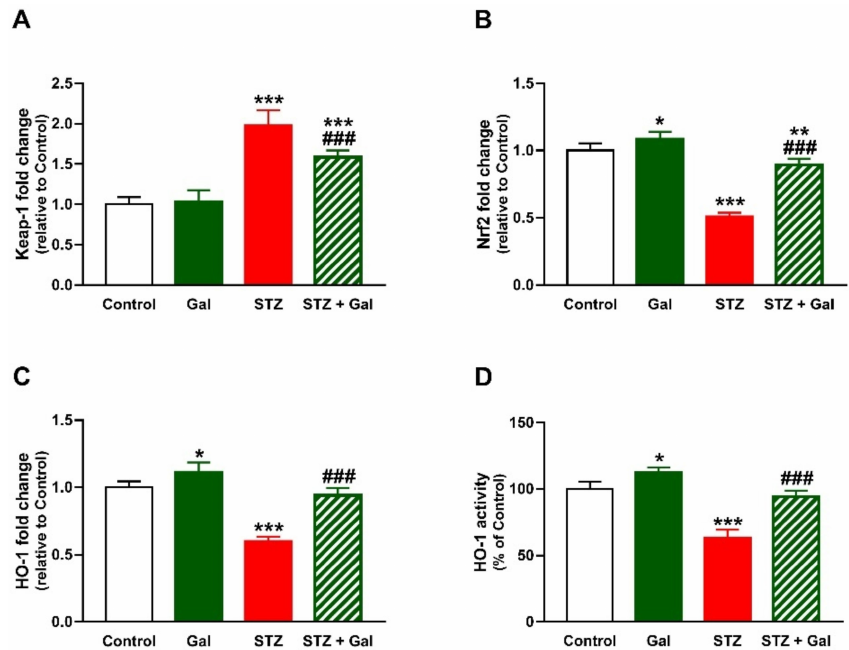
Figure 8. Galangin upregulates hepatic Nrf2/HO-1 pathway in diabetic rats. Galangin decreased hepatic Keap1 mRNA abundance in diabetic rats ( A ), and increased Nrf2 ( B ) and HO-1 ( C ) mRNA abundance, and HO-1 activity ( D ) in normal and diabetic rats. Data are mean ± SEM, n = 6. * p < 0.05, ** p < 0.01 and *** p < 0.001 versus control. ### p < 0.001 versus